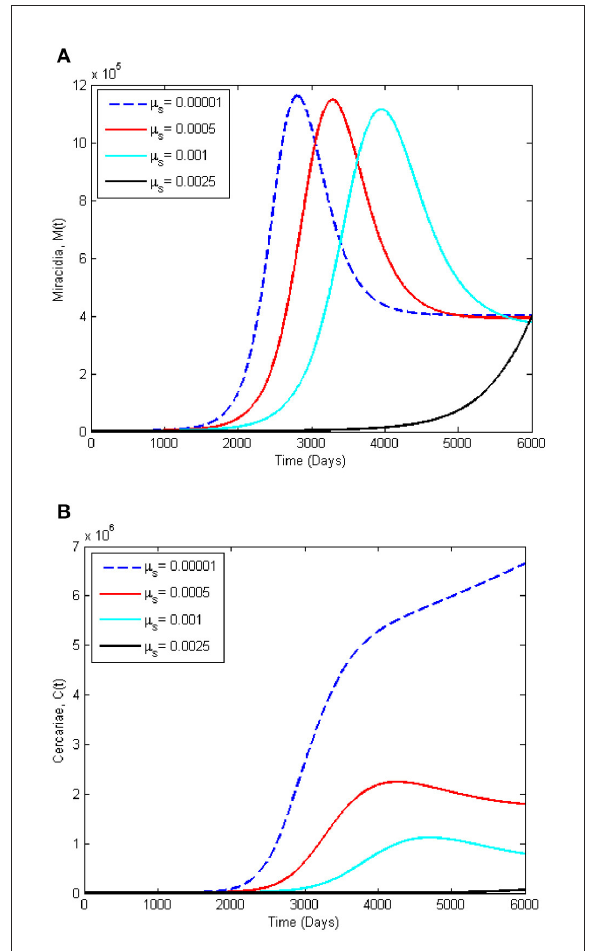
FIGURE6 Dynamics of Schistosomiasis infection among: (A) the Miracidia, ( M ( t )) and (B) the Cercariae classes, ( C ( t )), for varying snail death rate, µ s . All other parameters for this simulation are given in Table